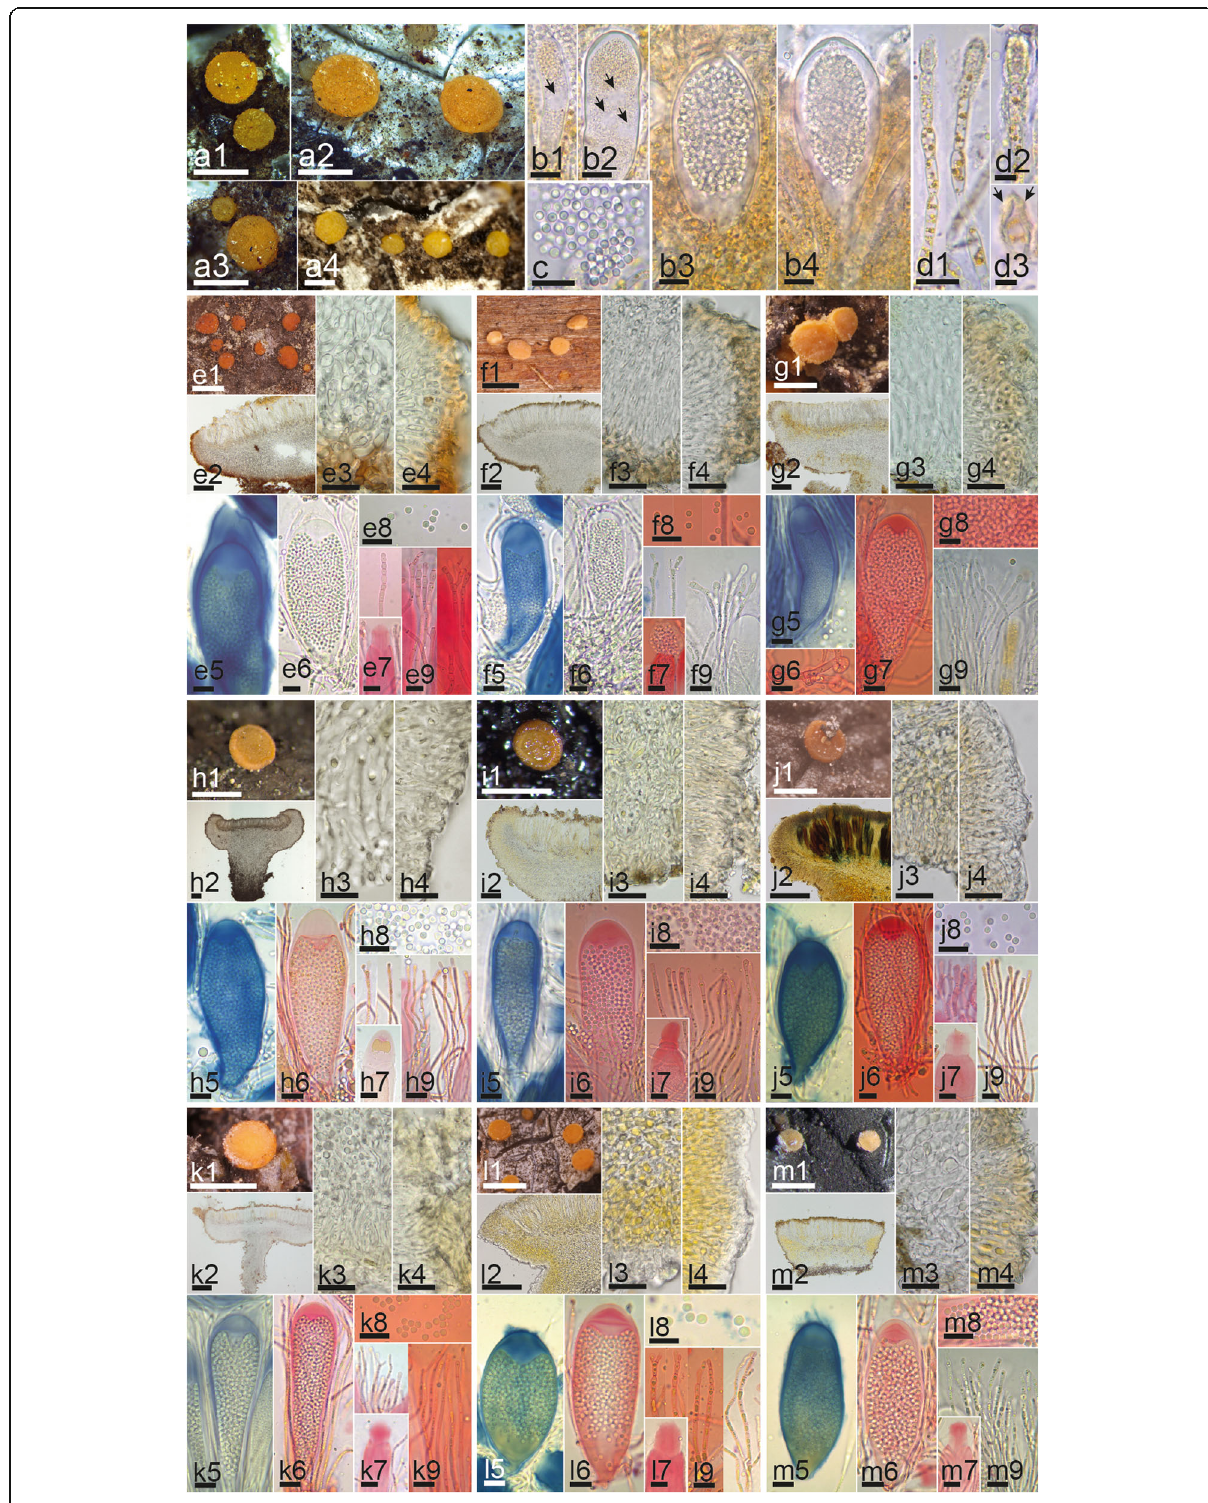
Fig. 2 (See legend on next